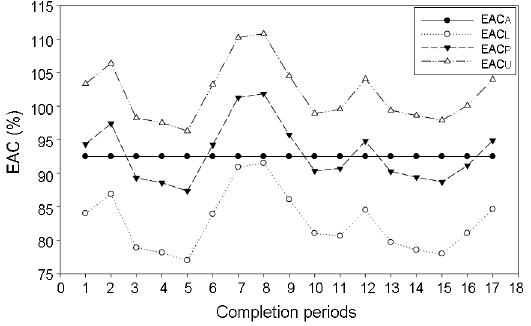
Fig. 9. EAC-LSMLPI prediction for project